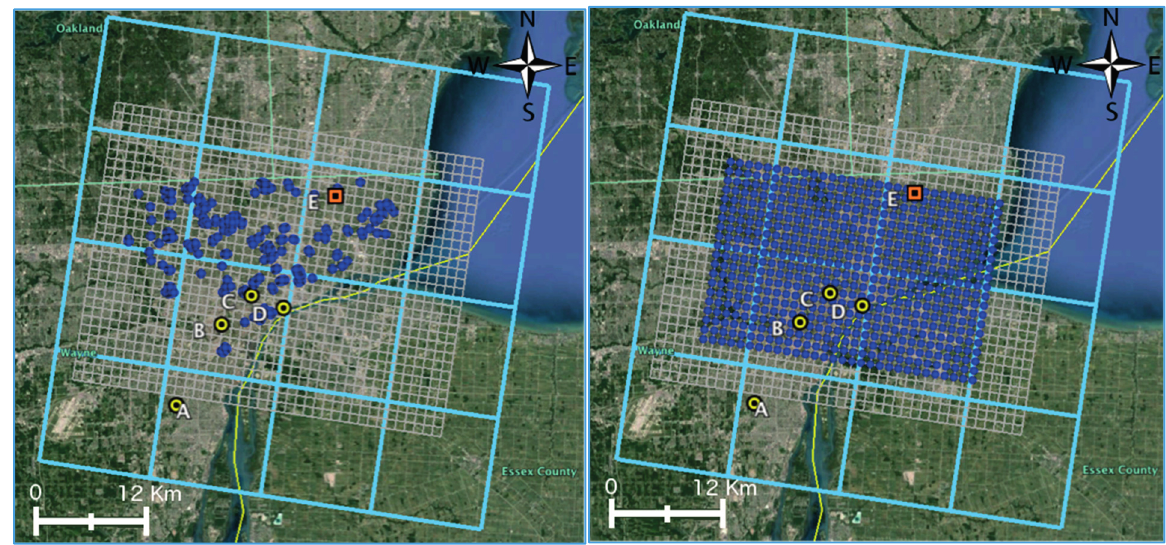
Figure 3. The cyan grid (CMAQ 12-km × 12-km grid) shows the 16 cells where local sources were removed. The grey grid (40 × 30 Detroit 1-km × 1-km grid) shows the location of the mobile and stationary emission sources. The blue circles indicate NEXUS ( left ) and Detroit grid ( right ) receptor locations. Yellow AQS sites labeled A through D represent PM 2.5 sites 261630001 (Deer Park), 261630033 (Dearborn), 261630038 (Newberry), and 261630039 (Ambassador Bridge), respectively. The orange AQS site labeled E represents NO x site 261630019 (E 7 Mile Road). The yellow line shows the U.S.-Canada